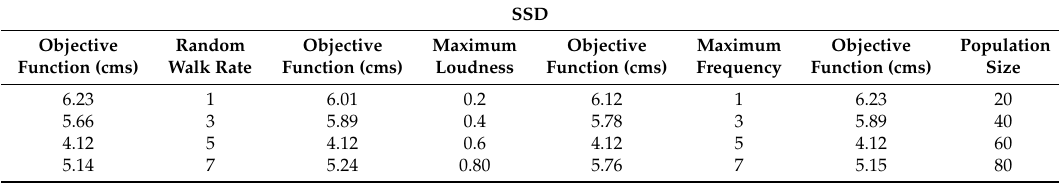
Table 1. Analysis for the performance of Improved Bat Algorithm (IBA) algorithm (Wilson flood).